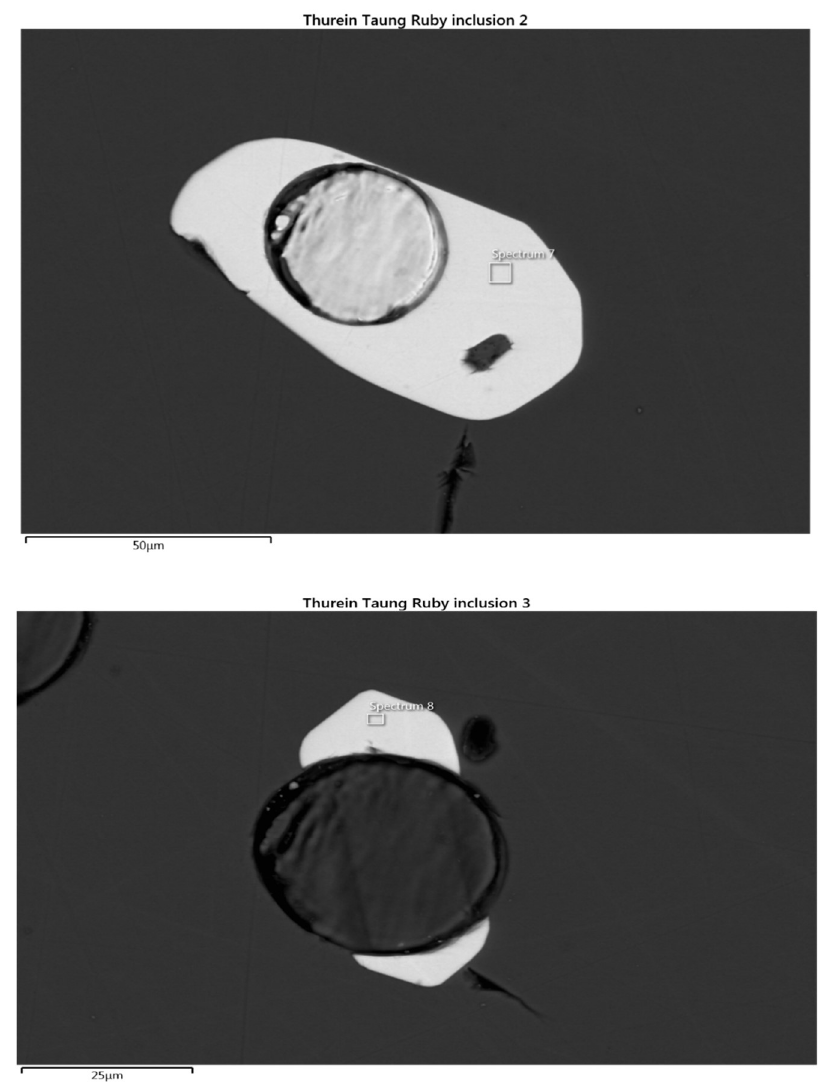
Figure 14. Zircon crystals in Thurein Taung ruby (background), showing circular age-dating pits and